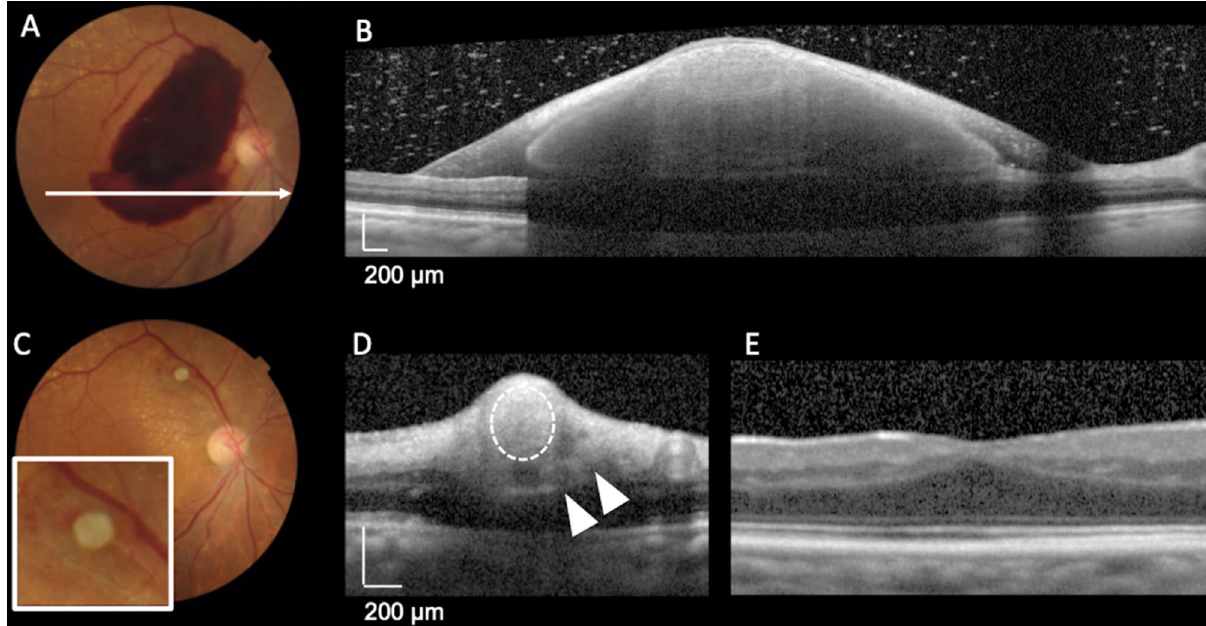
Figure 3. Representative case involving an 86-year-old woman with a ruptured retinal arterial macroaneurysm anterior to the affected artery (anterior type) in the right eye. Optical coherence tomography (OCT) performed in the acute phase shows a small amount of vitreous hemorrhage and a large amount of preretinal hemorrhage and sub-inner limiting membrane (ILM) hemorrhage. Subretinal hemorrhage is unremarkable ( B ). Eight days after onset, pars plana vitrectomy (PPV) with ILM peeling and direct photocoagulation of RMA were performed. On resolution of the hemorrhages, OCT shows that RMA is located anterior to the retinal artery ( D , arrows), and color fundus photography ( C ) shows that the organized white RMA is interrupting the course of the affected artery. Thus, it can be classified as the anterior type. After 24 months, there is no damage to the foveal photoreceptor layer ( E ); the visual acuity was